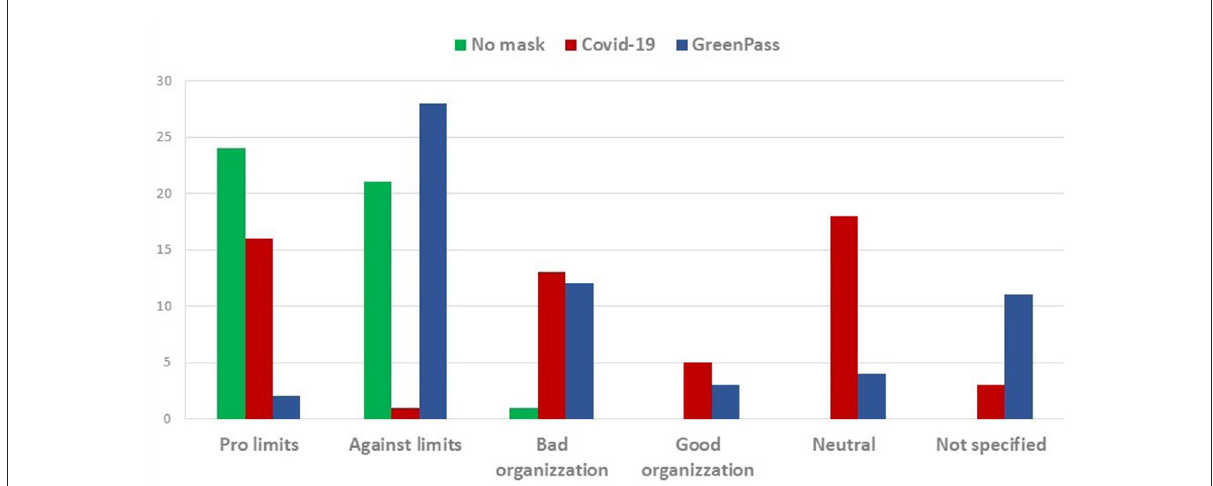
FIGURE3 Top 10 tweets: distribution of hashtag for policy evaluations against the spread of infections.